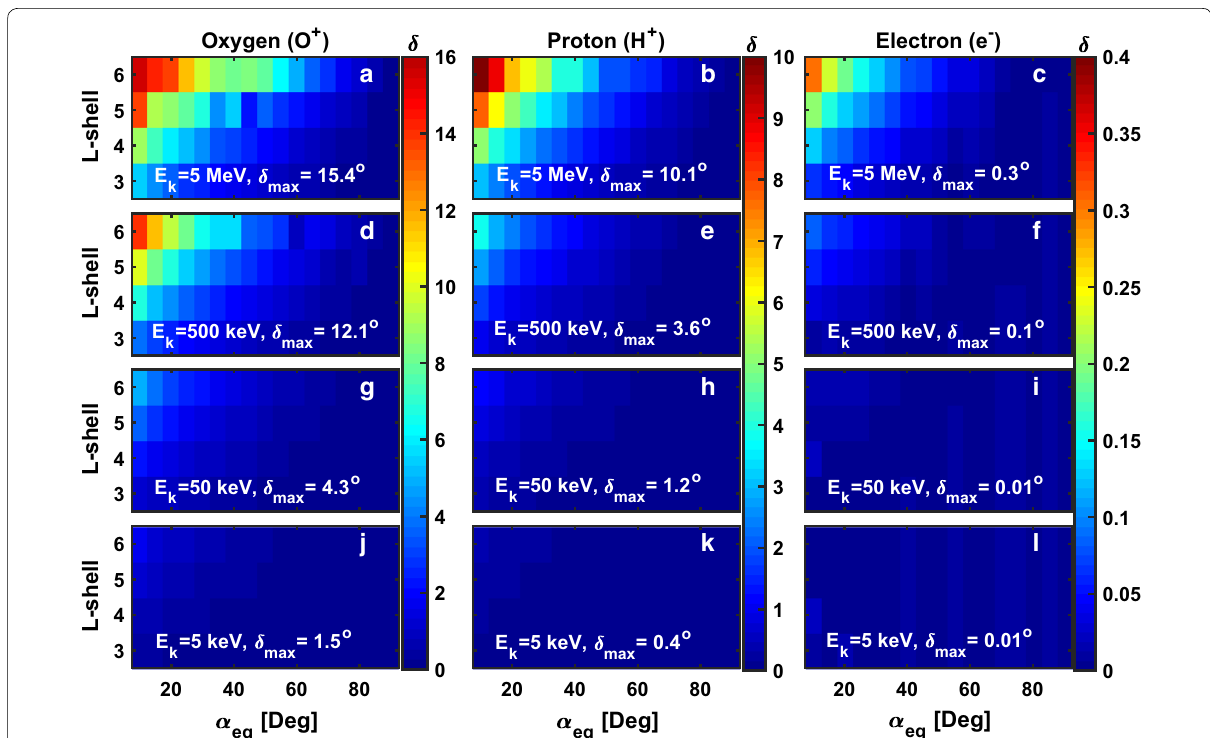
Fig. 5 The deviation of the theoretical and simulation results of magnetic mirror points as a function of the equatorial pitch angle for different L-shells. a , d , g , j are for oxygen ions, b , e , h , k are for proton, and c , f , i , l are for electrons. The magnitude of the absolute deviation is shown by the colour